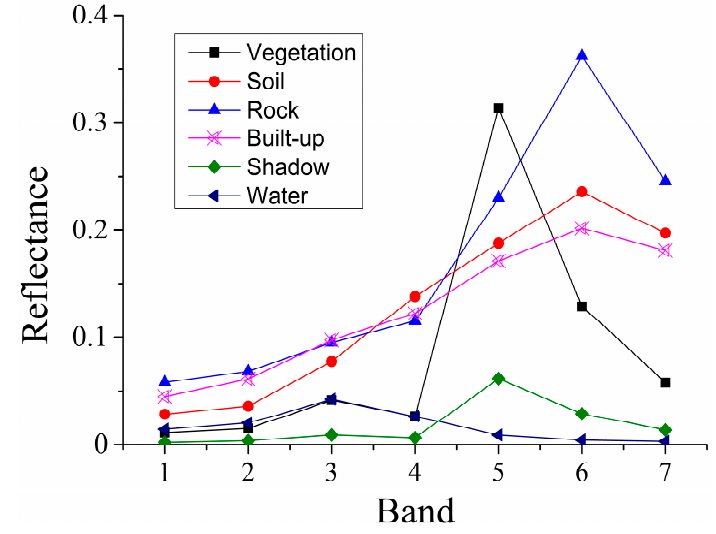
Figure 2. Reflectance spectra of each typical land-cover type in the Xiaojiang watershed. Values were derived from an average of 50 pixels for each land-cover type.